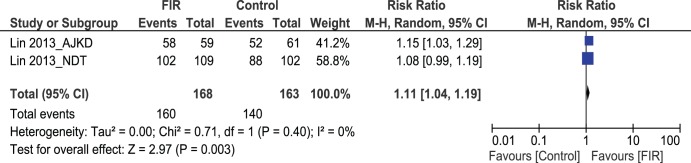
Forest plot showing assisted patency rates at 12 months.